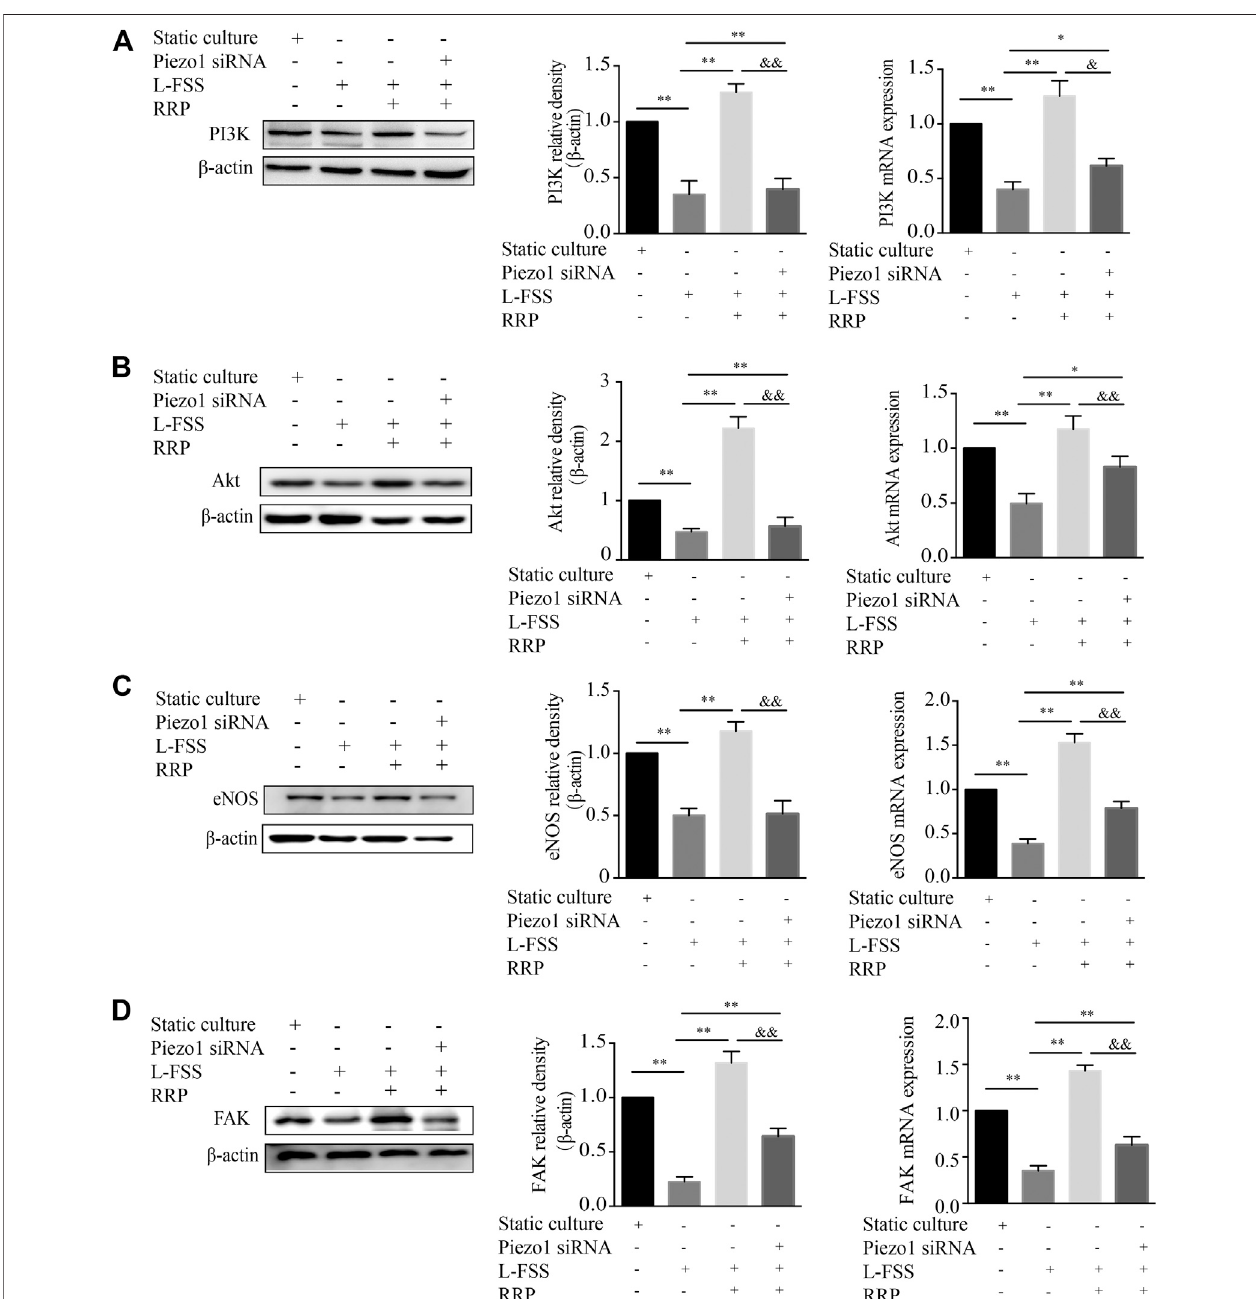
FIGURE 6 | RRP intervenes in the FAK-PI3K/Akt pathway. The mRNA and protein levels of PI3K (A) , Akt (B) , eNOS (C) , and FAK (D) were detected by qPCR and western blot, respectively. * p < 0.05, ** p < 0.001 vs. L-FSS group, & p < 0.05, && p < 0.001 vs. L-FSS + RRP group.